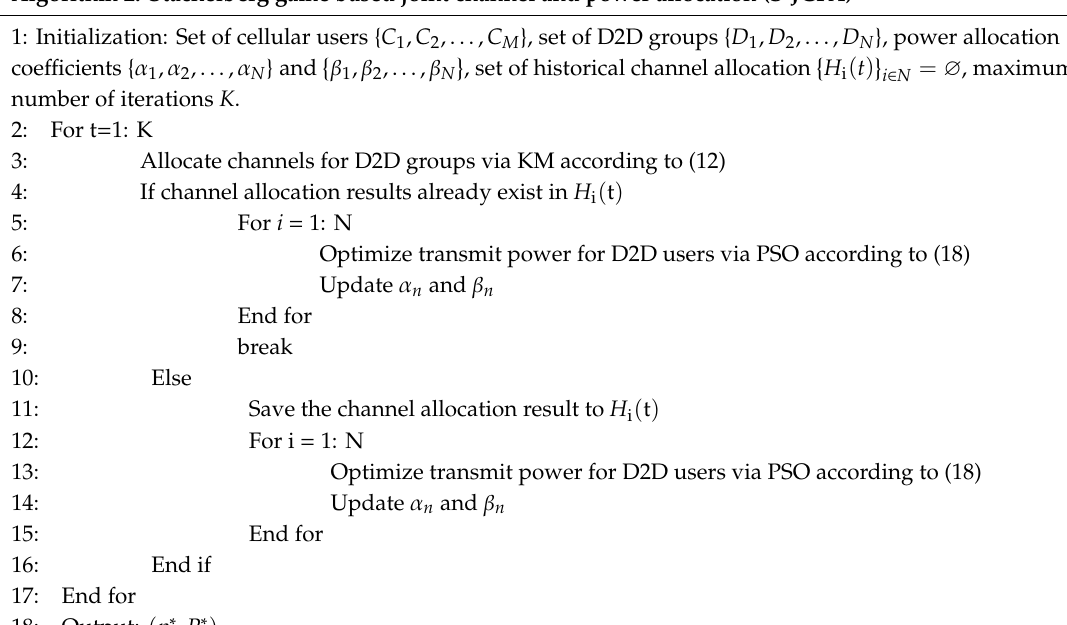
Algorithm 2. Stackelberg game based joint channel and power allocation (S-JCPA)